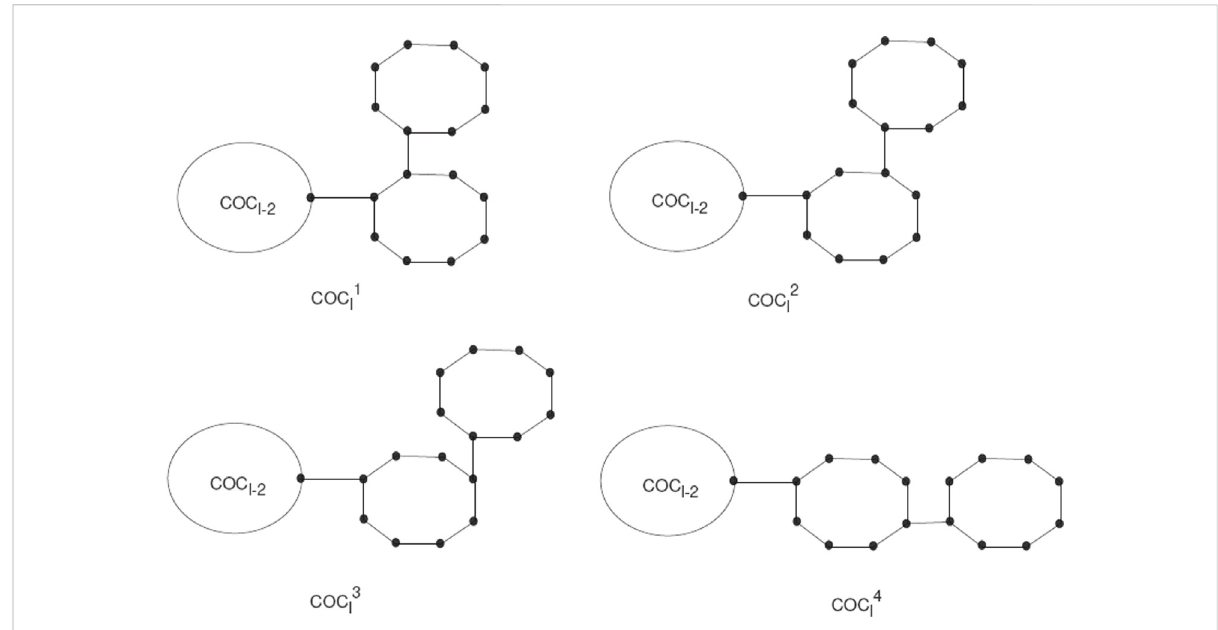
FIGURE 2 The four types of local arrangements of octagons COC 1 l , COC 2 l , COC 3 l and COC 4 l